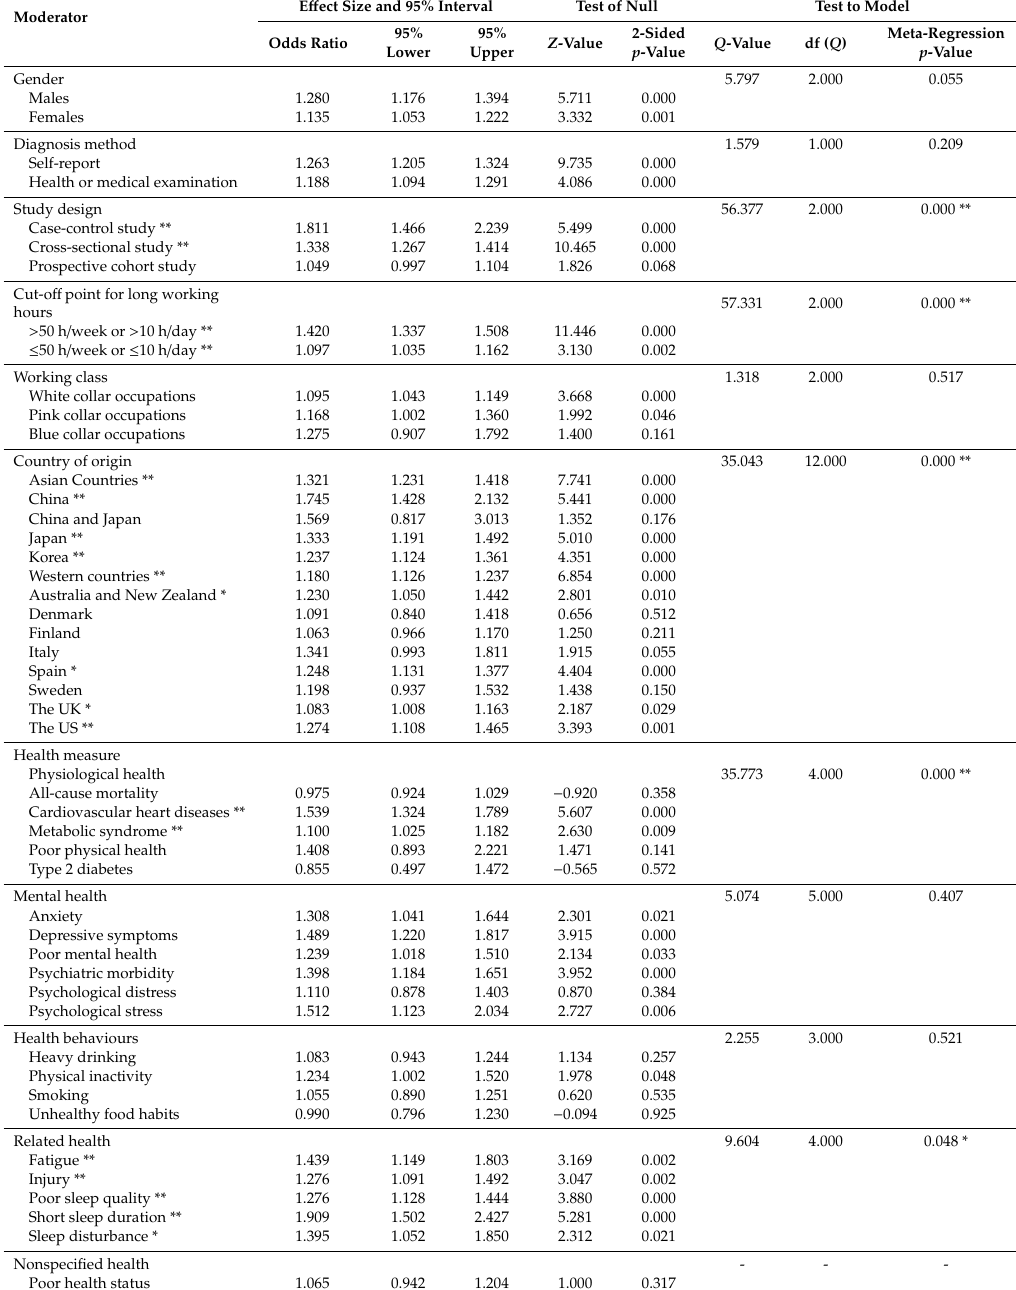
Table 3. The association of long working hours with occupational health in relation to gender, diagnosis, study design, cut-off point for long working hours, working class, country of origin and health measure for the conditions of physiological health, mental health, health behaviours, related health and nonspecified health (effect sizes adjusted, when appropriate, for age, gender, educational level and